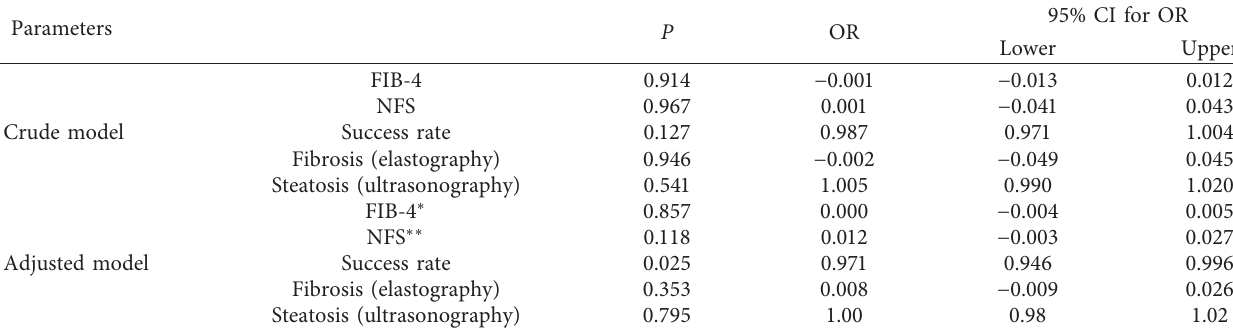
Table 5: The logistic regression analysis between PTH and study